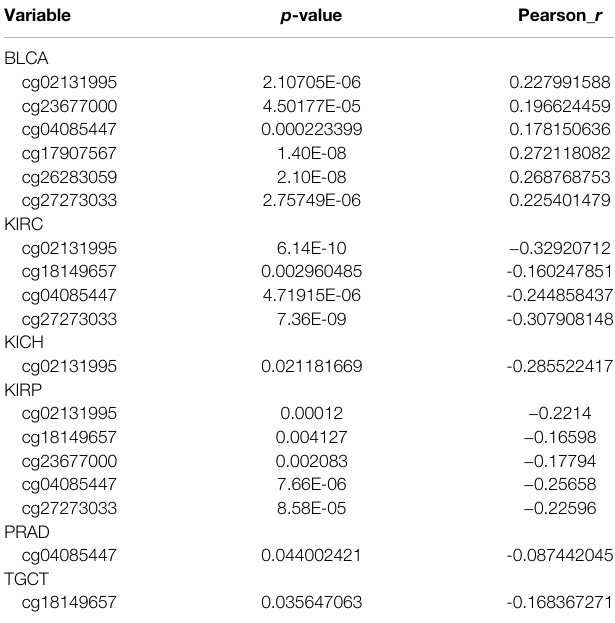
TABLE 2 | Signi fi cant correlation of DNA methylation and hepcidin expression at multiple probes. Variable